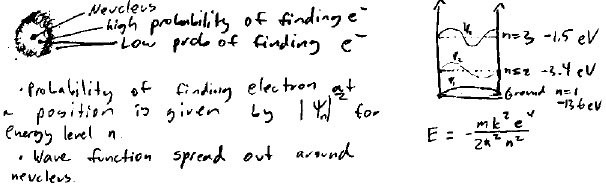
FIG. 5. Example of a student response coded as implicitly using the Schrödinger model only. This student drew an electron cloud and described how it characterized the probability of finding the electron at different locations, a characteristic of the Schrödinger model.